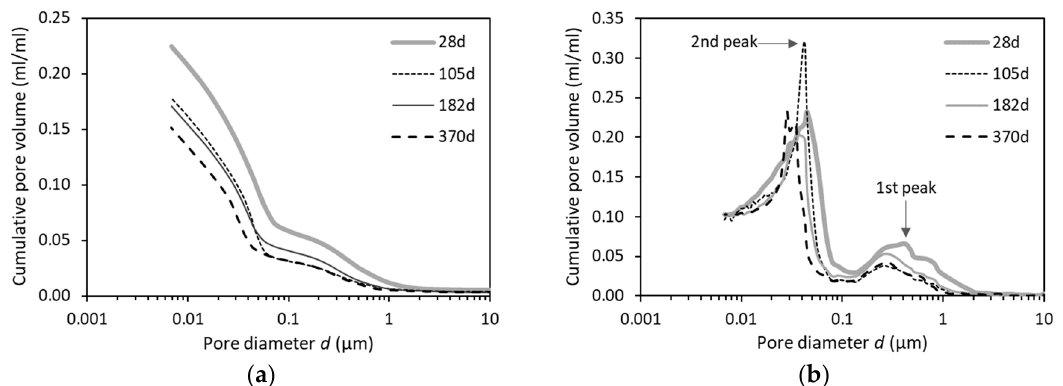
Figure 10. ( a ) Pore size distributions and ( b ) di ff erential curves in OPC pastes (w / b = 0.4) with di ff erent ages characterized by standard MIP measurements.